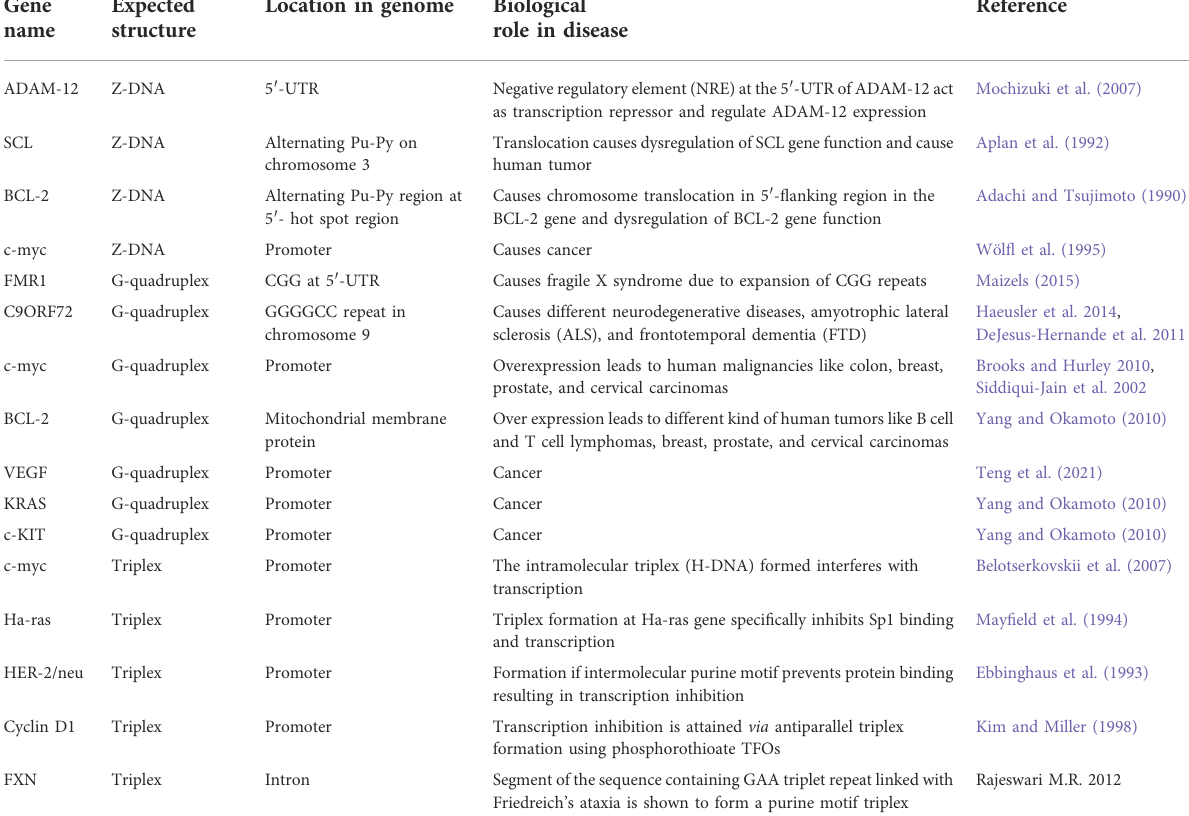
TABLE 3 Role of non-canonical structures in progression of cancer and neurological